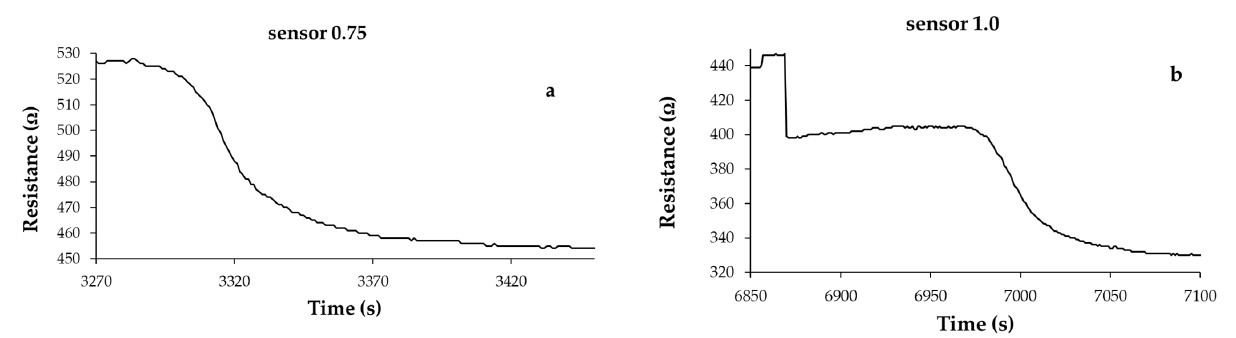
Figure 11. Response time of the RH resistive at room temperature for 40% RH–50% RH step: ( a ) sensor 0.75 and ( b ) sensor 1.0.